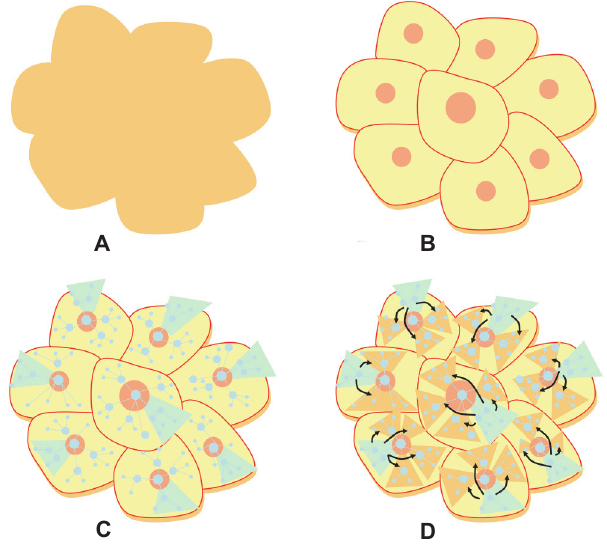
Figure 1. ( A ) Full geographic scale that we want to spread to, covering the entire country. ( B ) Administrative sub-divisions such as districts, provinces, or states represented as petals in a country. ( C ) Blue dots representing health facilities and community structures that provide service(s) in a country. ( D ) Movement of spread agents from their original facilities to facilities in other